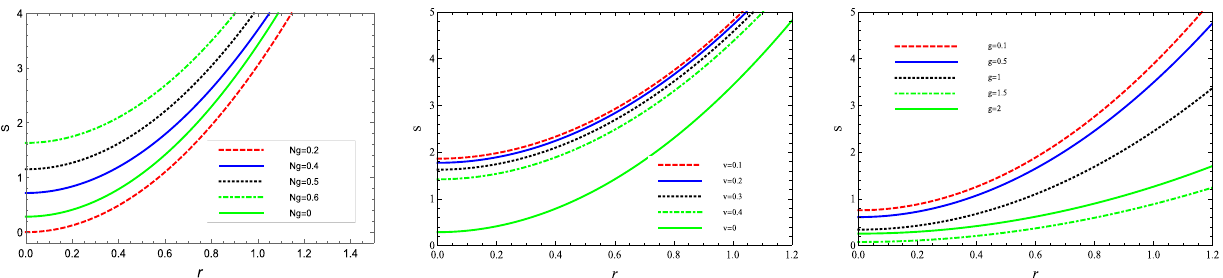
Fig. 5 The variation of entropy with ‘r’ for different values of (i) NUT charge N g , (ii) magnetic charge ν and (iii) gauge coupling constant g at a = 0 . 5 , M =